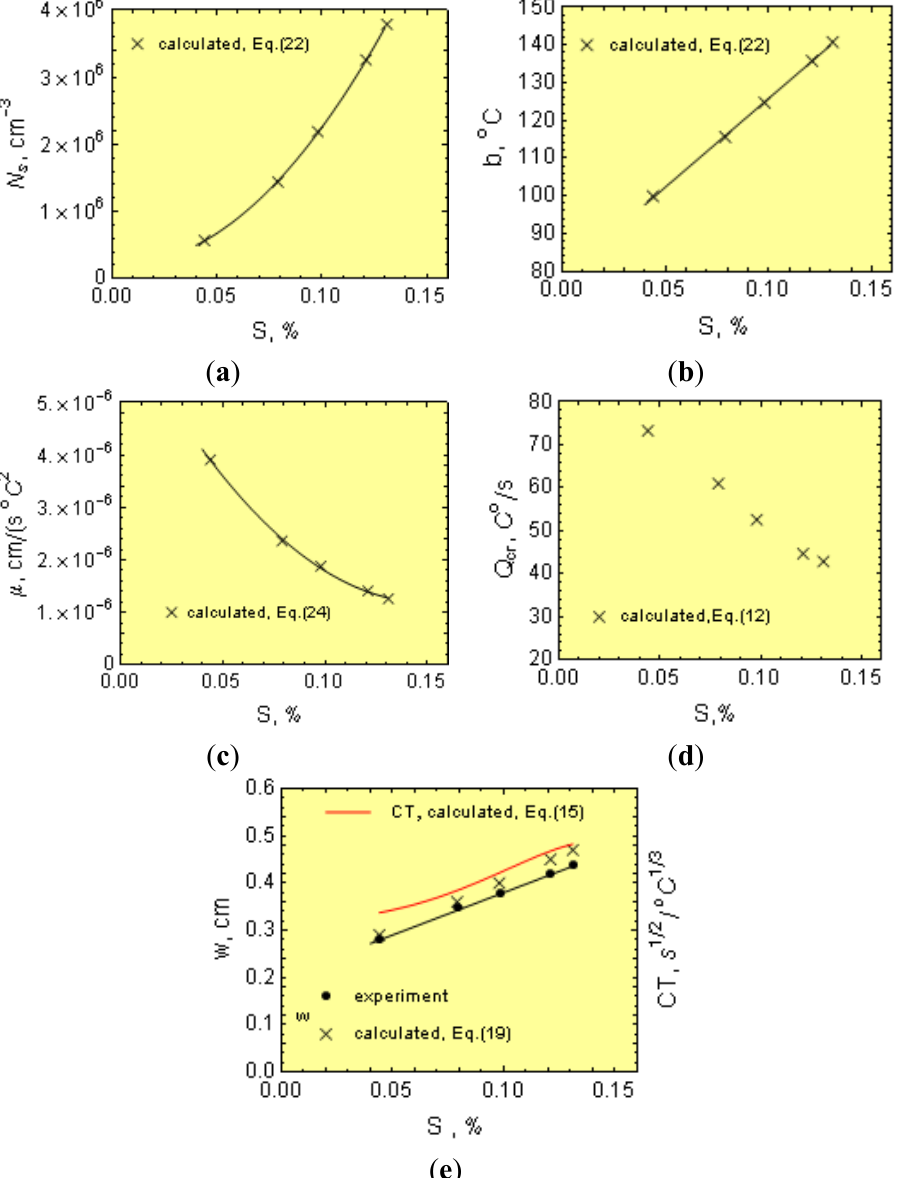
Figure 23. Effect of sulfur on ( a ) N s , ( b ) b , ( c ) μ, ( d ) CT index and ( e )